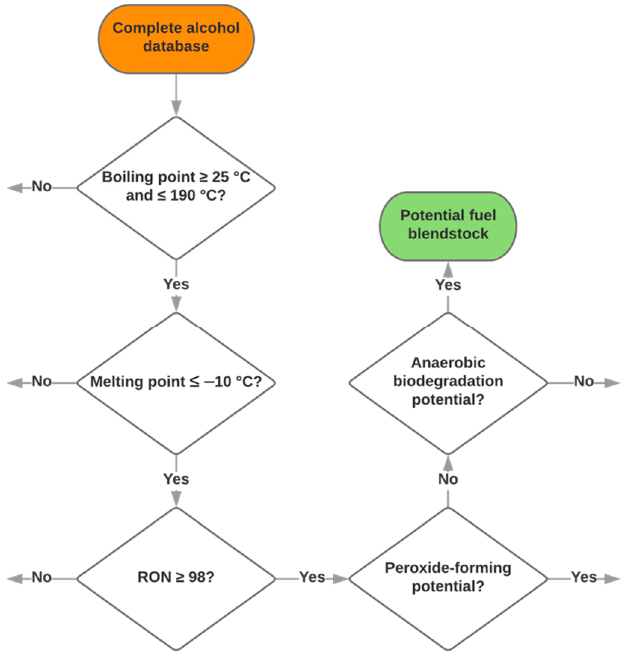
Figure 1. Decision framework for the first-stage screening of the alcohol database.